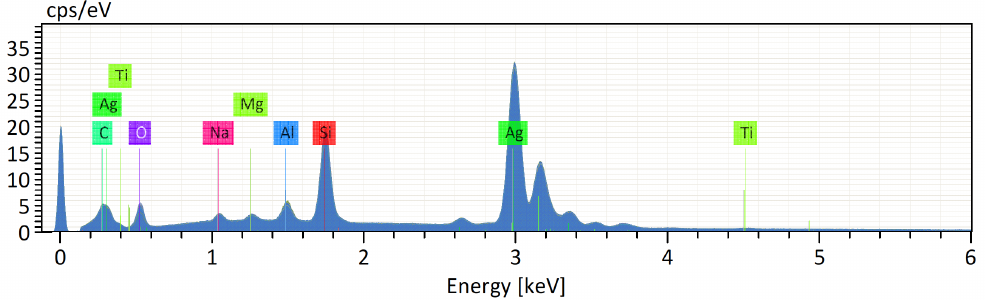
Figure 14. EDS analysis yields an X-ray spectrum, with characteristic peaks for each element present. Comparing peak ratios of reliable elements, like Si, to the elements of the thin film, Ag and Ti, it is possible to calculate film thickness using spectrum analyzer software developed at the National Institute of Standards and Technology